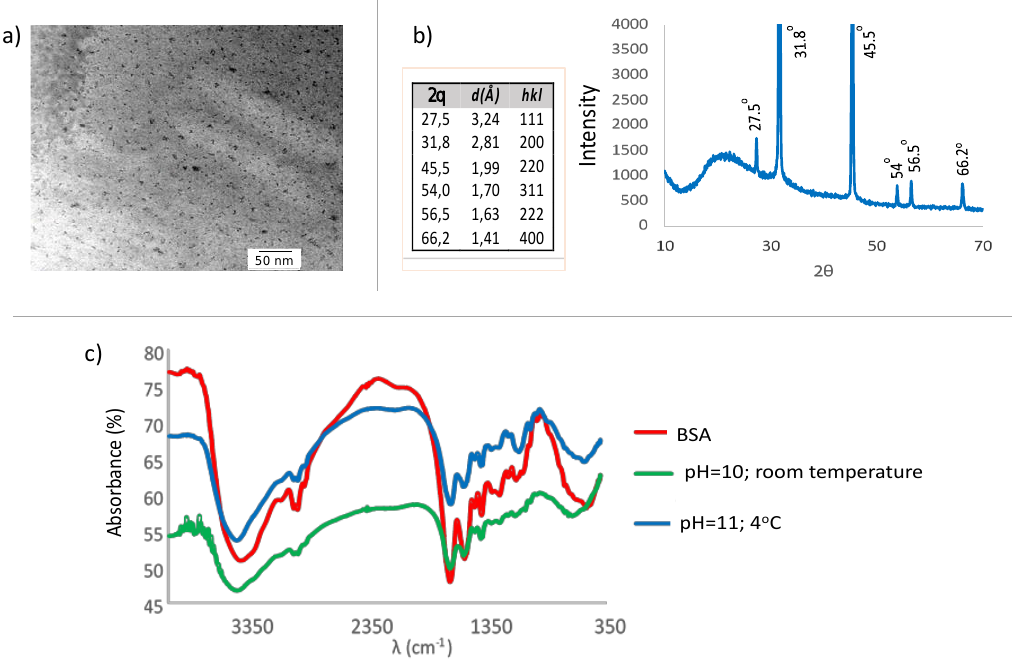
Figure 7. ( a ) Transmission electron microscopy (TEM) image of the CdS nanoparticles; ( b ) 1 indices hkl for the zinc blende structure for the CdS. Powder X-ray diffraction (XRD) pattern of the CdS particles; ( c ) Infrared spectra of the CdS nanoparticles. FT-IR spectra (Fourier Transform InfraRed spectra) of BSA and of CdS QDs prepared at pH 10 (room temperature) and at pH 11 (4 °C). InFigure7, itisdisplayedthediffractogramanddiffractionangles, thecorrespondingdistances